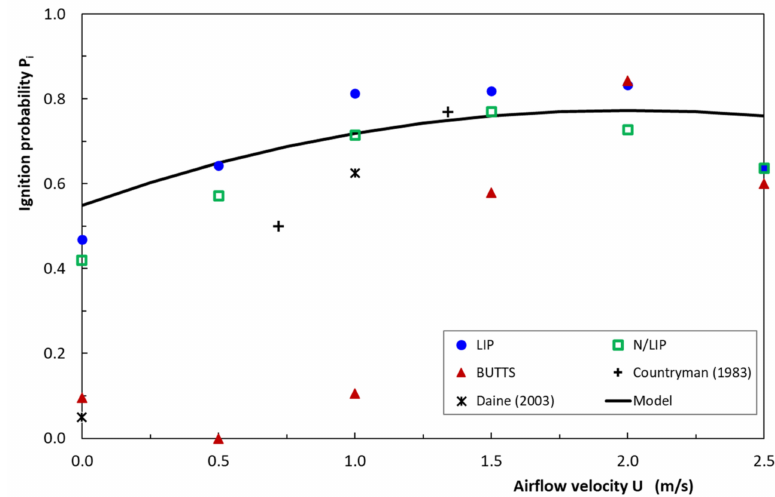
Figure 15. Average values of the ignition probability P i as a function of the airflow velocity for tests with Lower Ignition Propensity (LIP), No Lower Ignition Propensity (N/LIP) and butts. Results obtained by other authors area also presented and used to be compared with the model prediction (Equation (40)).